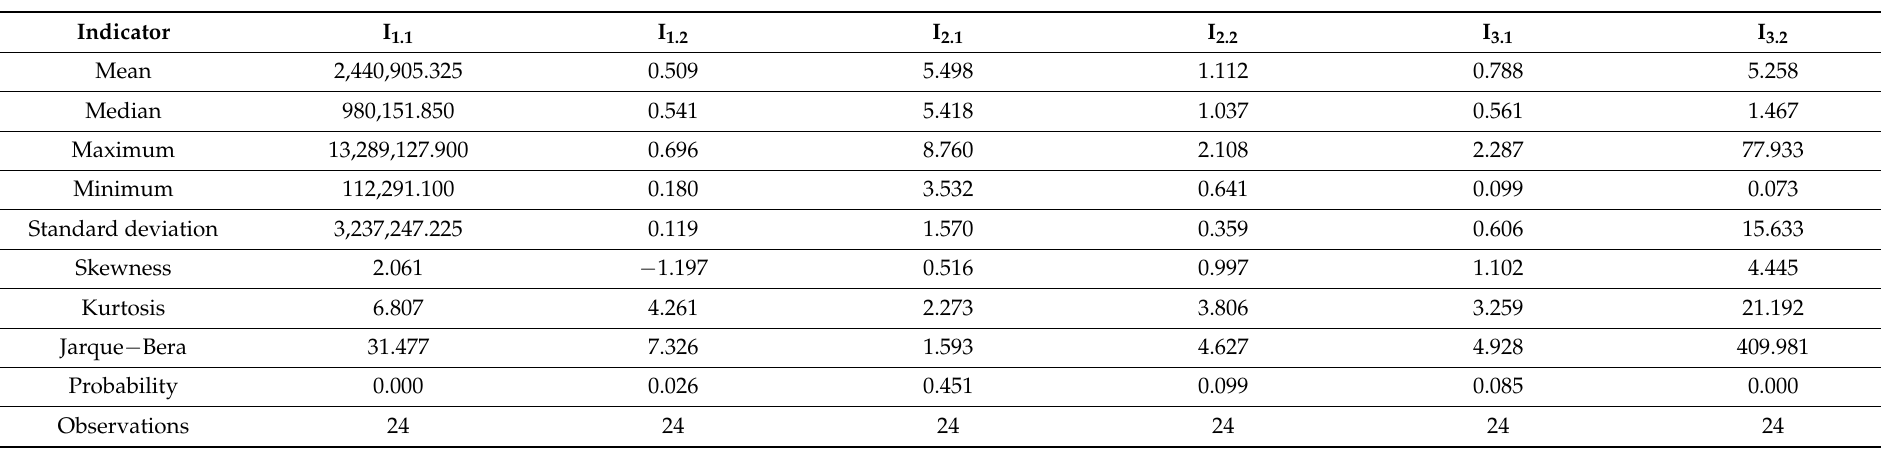
Table 2. Descriptive statistics of the indicators used to construct the sustainable economic competitiveness index ( SECI